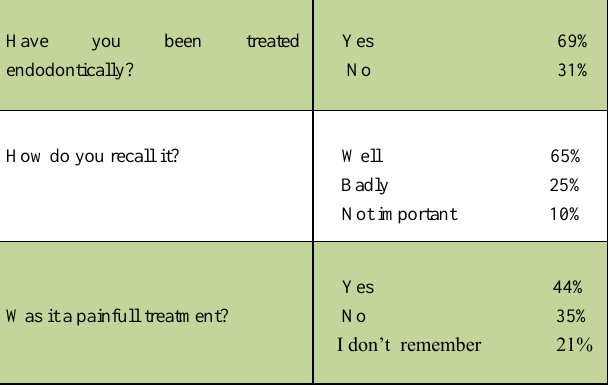
Table 2. Criteria of symptoms confirming the need for treatment reported by patients.